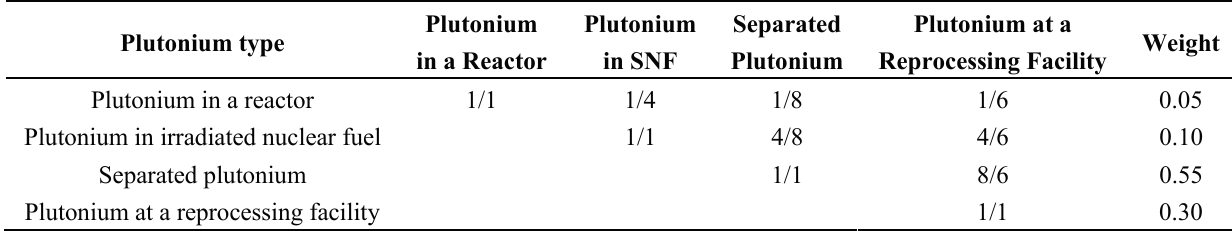
Table 6. Pairwise comparisons of various plutonium